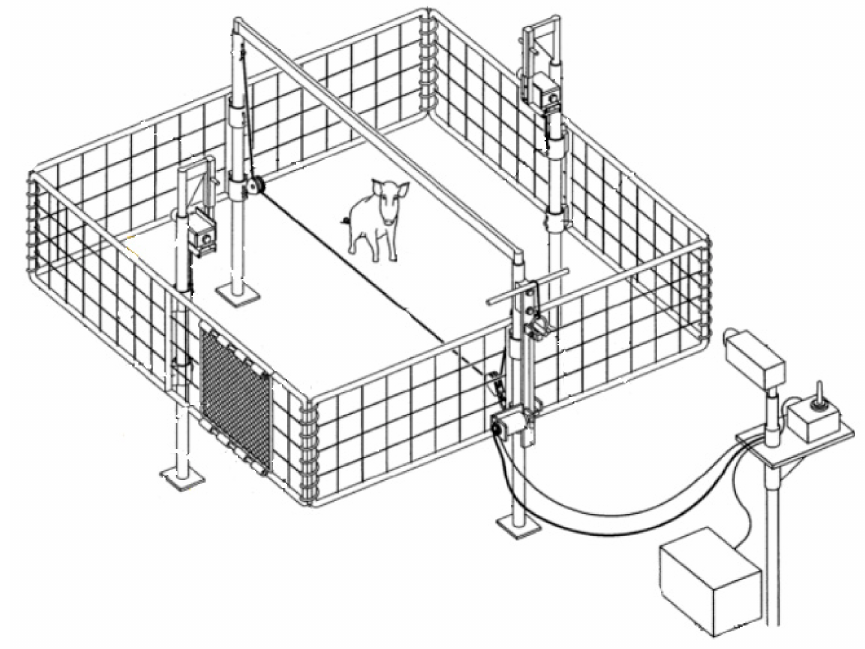
Figure 6. Suspended trap configuration (4.9 m (l) × 4.9 m (w) × 1.5 m (h)) used on Coffey, Oswalt Road and Red River ranches, Love County, OK, USA to trap wild pigs ( Sus scrofa ). Diagram courtesy of Noble Research Institute, LLC (Ardmore, OK,